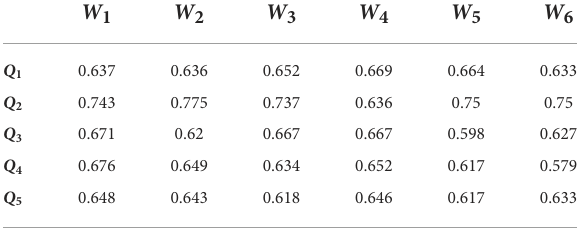
TABLE 7 The numbers of Hamming distance.